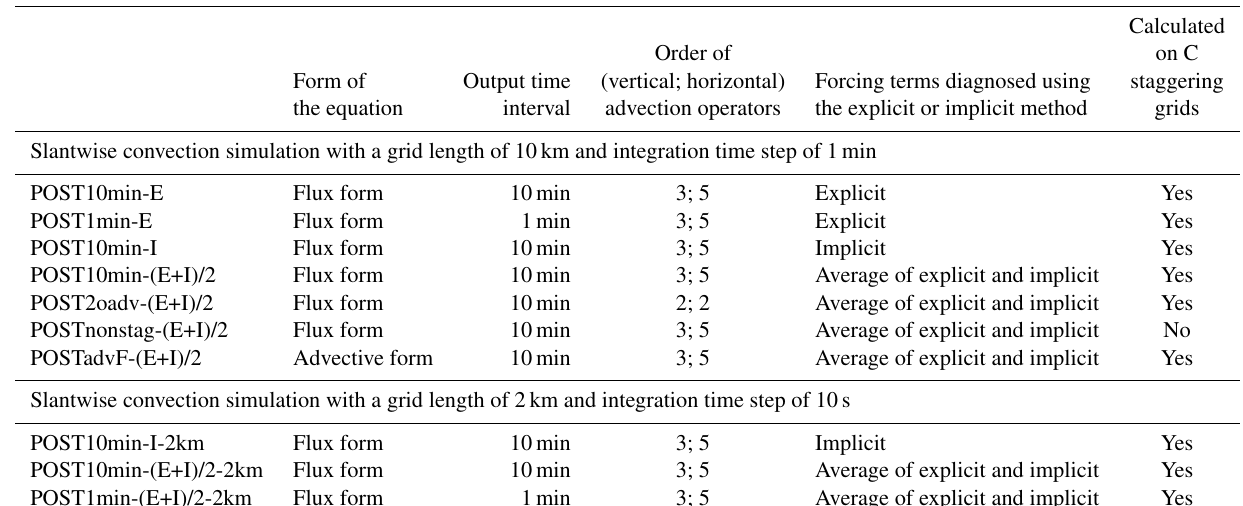
Table 1. A summary of all different approaches for the post-processed horizontal momentum budget analysis that are applied to the model output after the integration finishes.